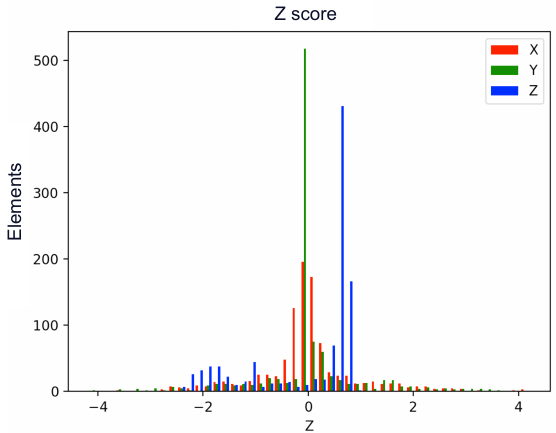
Figure 19. Z-score values of scene 1, before finding the barycenter.